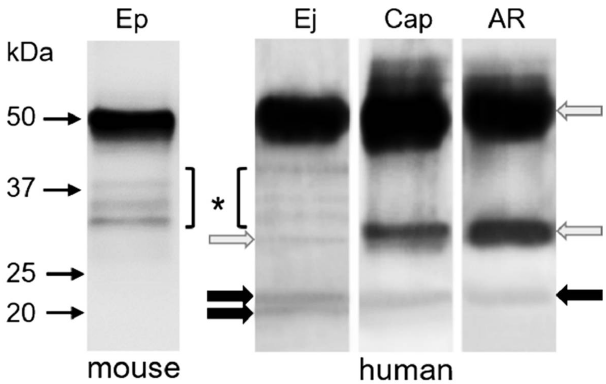
Figure 6. Co-immunoprecipitation of CD9 and CD81 molecules from lysates 5 × 10 7 of mouse epididymal sperm (Ep), and human sperm (Ej—ejaculated, Cap—capacitated, AR—acrosome-reacted). Detection of CD81 tetraspanin with polyclonal rabbit antibody anti-CD81 (H-121) in CD9 immunoprecipitates using polyclonal rabbit antibody (H-110); grey arrows—heavy and light chains from antibody, black arrows—antibody reaction, * protein bands from rabbit antiserum.